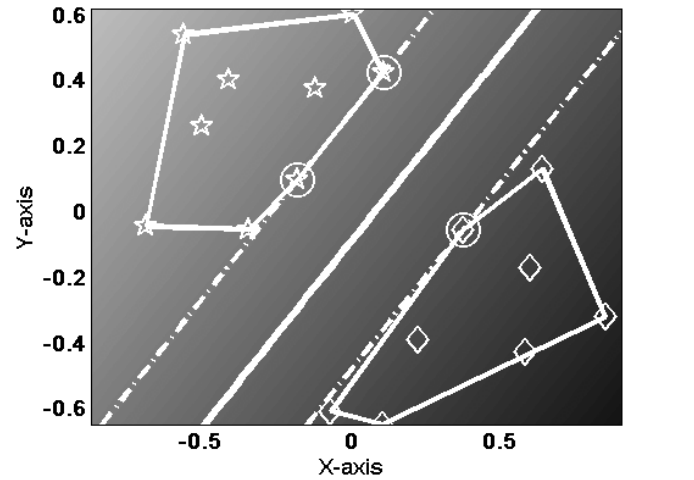
Figure 1. Convex hulls of samples in the feature space for SVM.